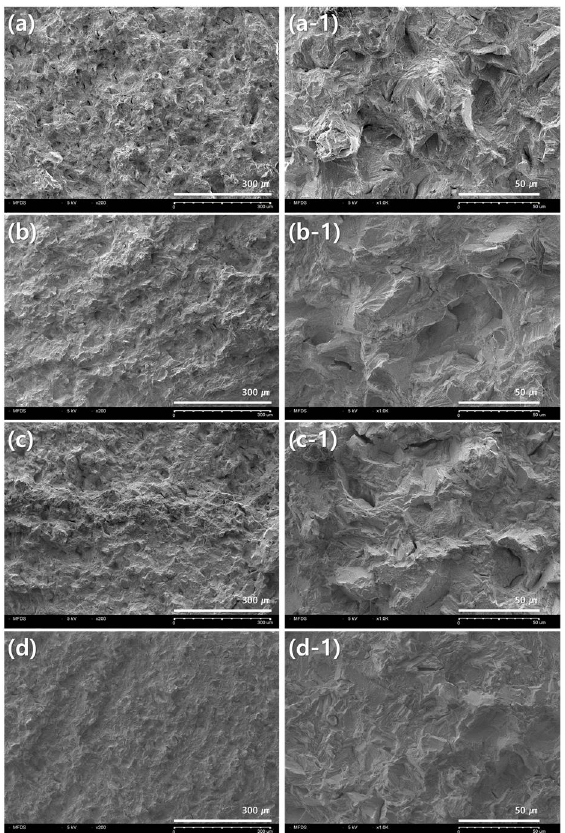
Figure 6. Observation of microstructure of fracture surface after tensile test of 3D printing group: ( a , a-1 ) 0 degree; ( b , b-1 ) 30 degree; ( c , c-1 ) 60 degree; ( d , d-1 ) 90 degree; ( a – d ) × 200; ( a-1 – d-1 ) × 1000.